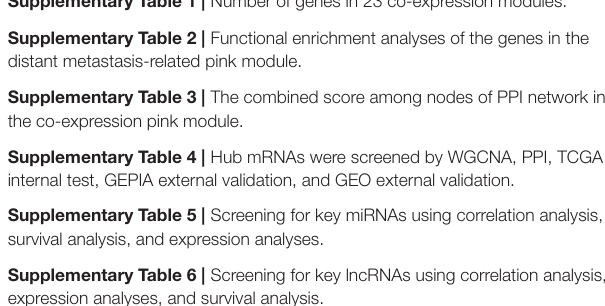
Supplementary Figure 2 | Survival analyses of 33 PPI hub mRNAs in the TCGA set. The value of p < 0.05 was considered statistically significant. PPI, protein–protein interaction; TCGA, the cancer genome atlas. Supplementary Figure 3 | Expression analyses and survival validation of six hub mRNAs. Expression analyses of BUB1B (A) , CCNB2 (B) , KIF18B (C) , PLK1 (D) , PTTG1 (E) , and TOP2A (F) in different stages. Expression analyses of BUB1B (G) , CCNB2 (H) , KIF18B (I) , PLK1 (J) , PTTG1 (K) , and TOP2A (L) between normal tissues and tumor tissues. OS validation of TOP2A (M) , BUB1B (N) , CCNB2 (O) , PTTG1 (P) , PLK1 (Q) , and KIF18B (R) in GEPIA database. DFS validation of TOP2A (S) , BUB1B (T) , CCNB2 (U) , PTTG1 (V) , PLK1 (W) , and KIF18B (X) in GEPIA database. The value of p < 0.05 was considered statistically significant. OS, overall survival; DFS, disease free survival; GEPIA, Gene Expression Profiling Interactive Analysis. Supplementary Figure 4 | Expression pattern validation in GEO dataset. Expression analyses of BUB1B (A) , CCNB2 (B) , KIF18B (C) , PLK1 (D) , PTTG1 (E) , TOP2A (F) among different stages. Expression levels of BUB1B (G) , CCNB2 (H) , KIF18B (I) , PLK1 (J) , PTTG1 (K) , TOP2A (L) between tumor tissues and normal tissues. The value of p < 0.05 was considered statistically significant. GEO, Gene expression omnibus. Supplementary Figure 5 | Target miRNAs associated with overall survival. The value of p < 0.05 was considered statistically significant. miRNAs, micro RNAs. Supplementary Figure 6 | Expression levels of 11 tumor suppressor miRNAs between ccRCC/KIRC tissues and normal tissues. The value of p < 0.05 was considered statistically significant. miRNAs, micro RNAs, ccRCC, Clear cell renal cell carcinoma. Supplementary Figure 7 | Screening of distant metastasis-related lncRNAs by intersection with pink module and expression correlation analyses. Venn diagram of target lncRNAs for hsa-miR-10b-3p (A) , hsa-miR-23b-3p (B) , and hsa-miR-139-3p (C) . (D) The expression correlation between hsa-miR-10b-3p and AC107021.2. (E) The expression correlation between hsa-miR-10b-3p and LINC01234. (F) The expression correlation between hsa-miR-23b-3p and AC107419.1. (G) The expression correlation between hsa-miR-23b-3p and AC112493.1. (H) The expression correlation between hsa-miR-23b-3p and